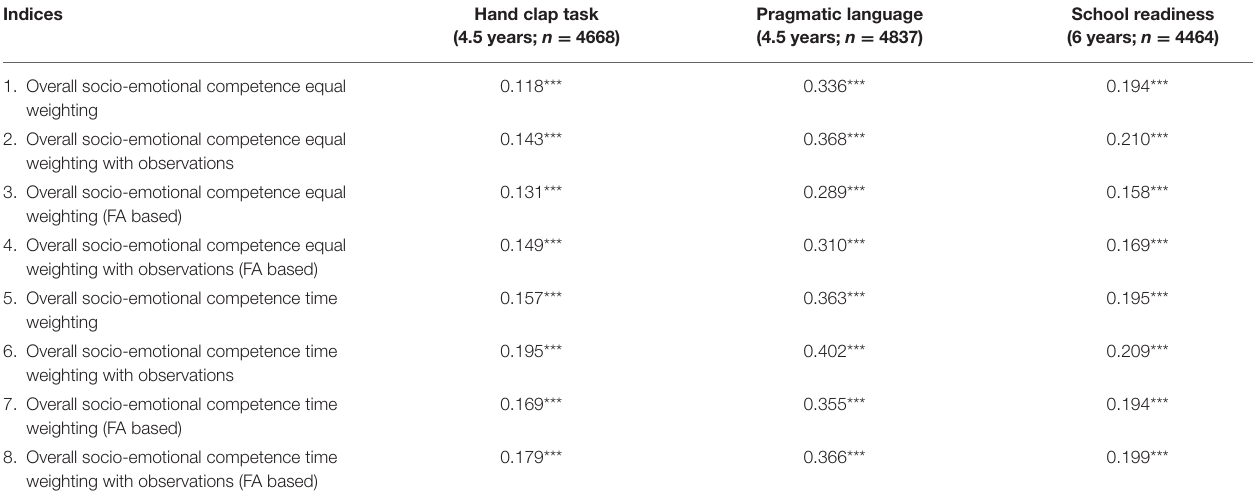
TABLE 4 | Correlations between the eight different indices and handclap total score (4.5 years), pragmatic language (4.5 years), and school readiness (6 years). Indices